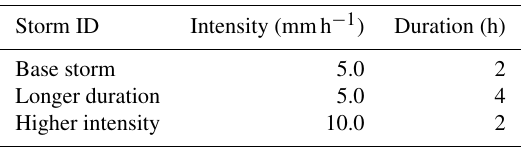
Table 4. Precipitation parameters for the three storm cases routed across the test